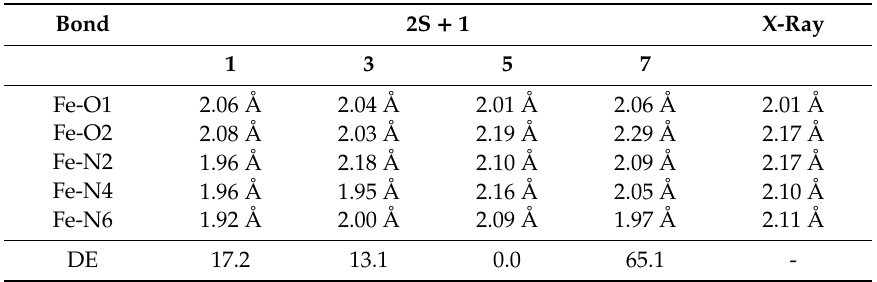
Table 1. Main geometrical parameters for naked complex a at all the spin states. Relative energies provided at M06L level of theory are kcal / mol and compared with the experimental X-ray counterpart [3]. Distances are in Å. See Scheme 1 for labels.